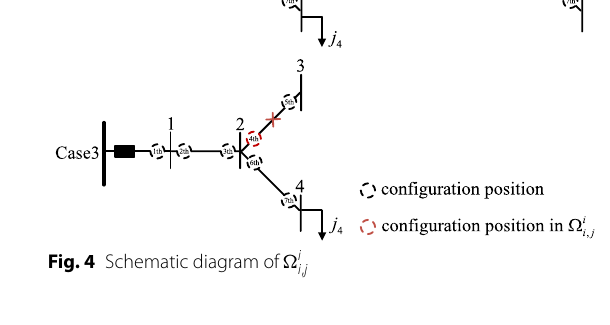
Fig. 4 Schematic diagram of (cid:31) i i ,